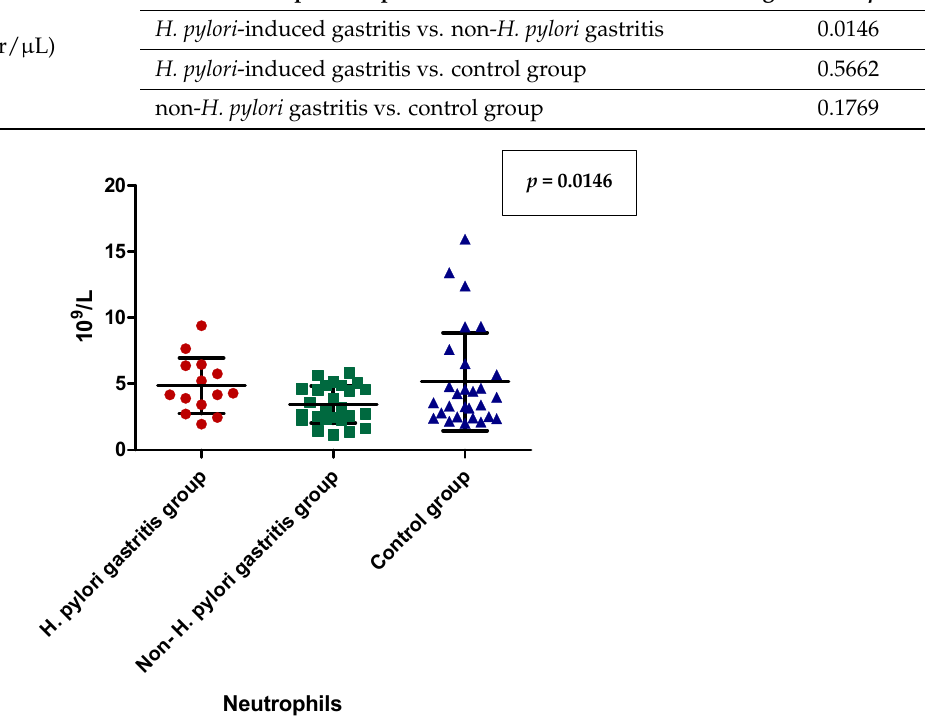
Figure 3. The difference of median values of neutrophils between the three groups.